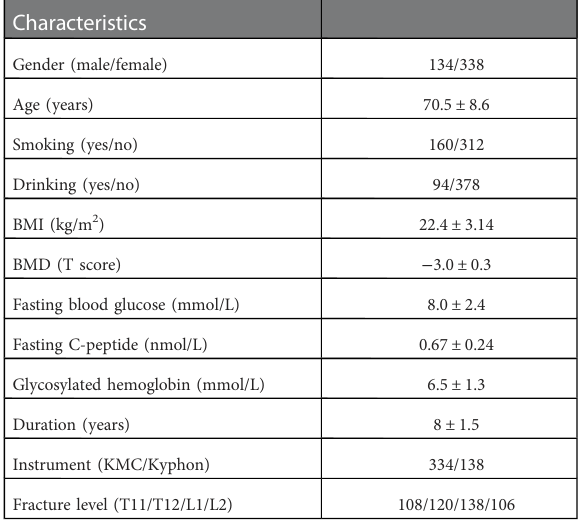
TABLE 1 Descriptive statistics of all patients ( n =472).